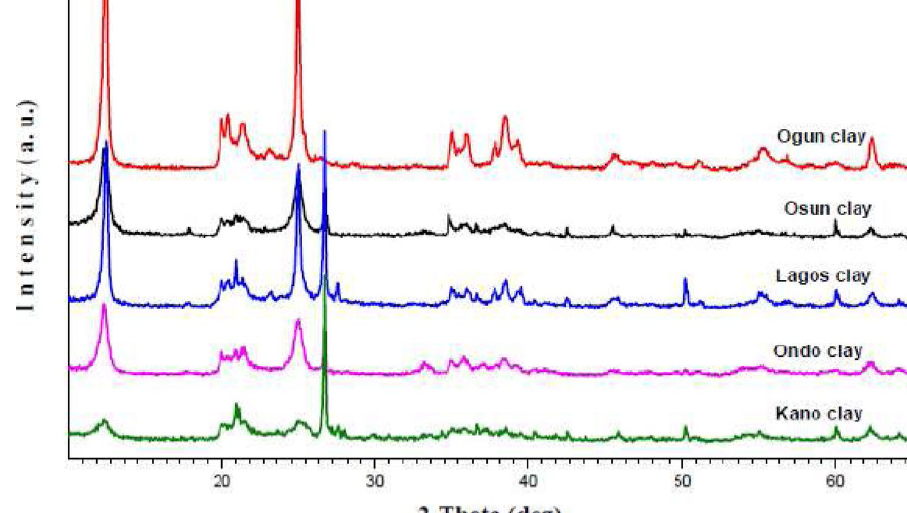
Fig. 3 X-Ray diffraction of selected clays from parts of Nigeria (Olubayode et al. 2016)